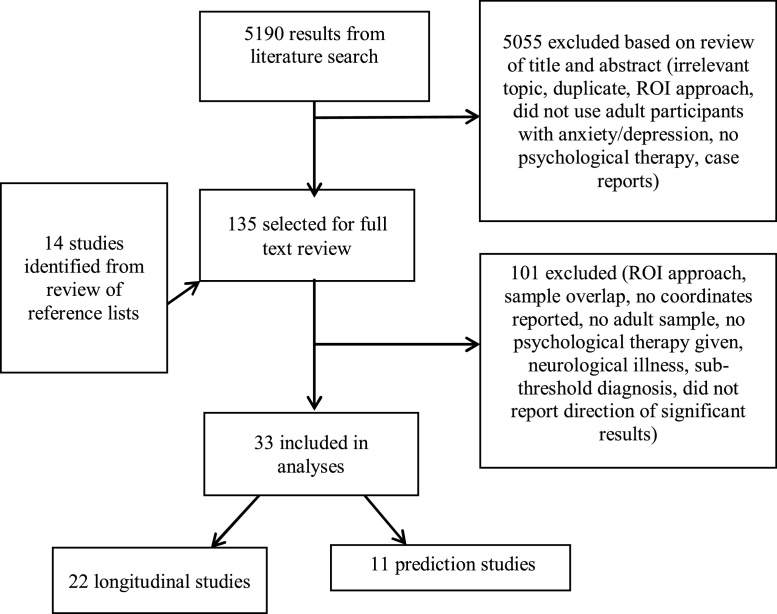
Flowchart of process of publication selection.Abbreviations – ROI, Region of Interest.